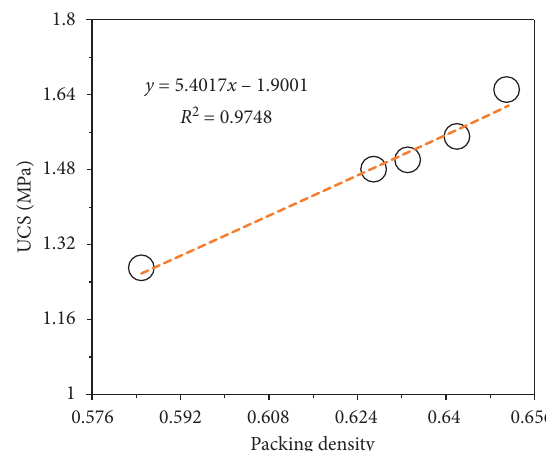
Figure 10: Relationship between packing density and UCS.